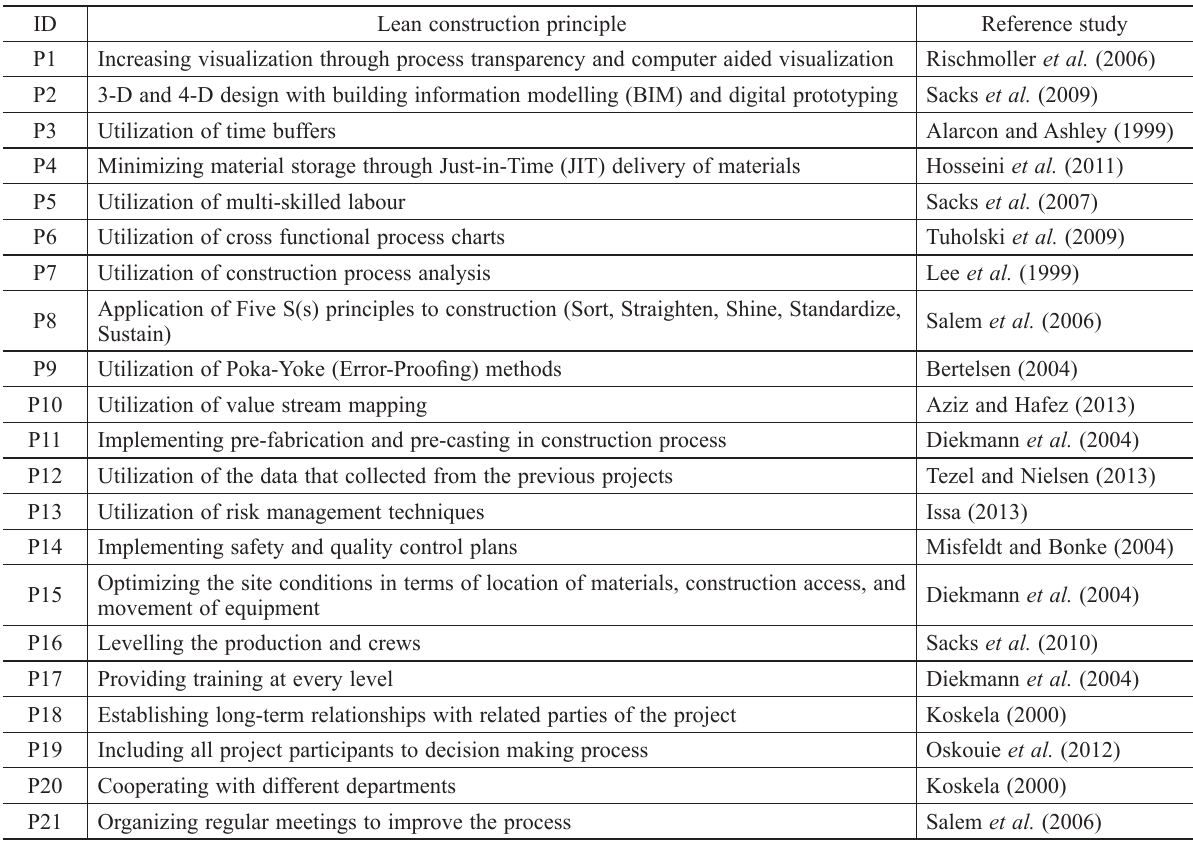
Table 1. Practical applications of lean construction principles